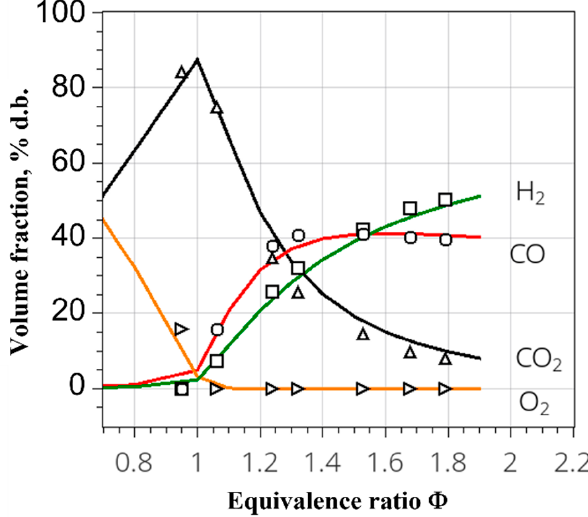
Figure 9. Comparison of measured (symbols) and calculated (curves) volume fractions of cooled dry detonation products of CH 4 /O 2 mixture. The calculation is made for the composition freezing temperature 2200 K.